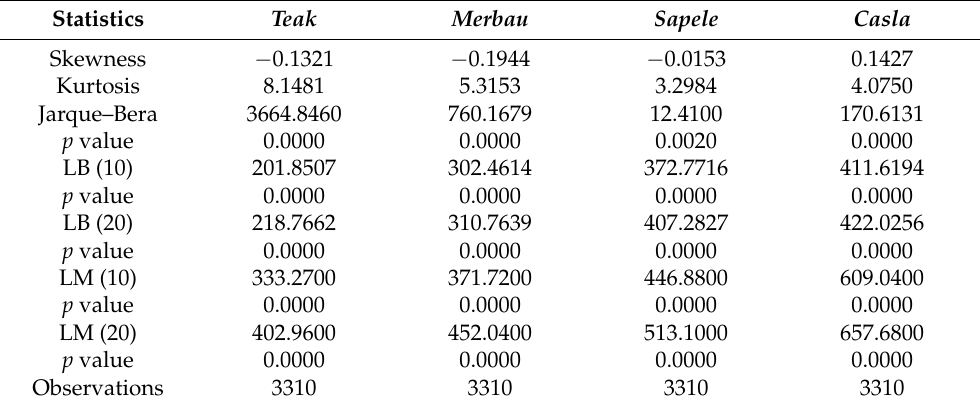
Table 2. The statistical characteristics for the price returns of major hardwood lumber imported by